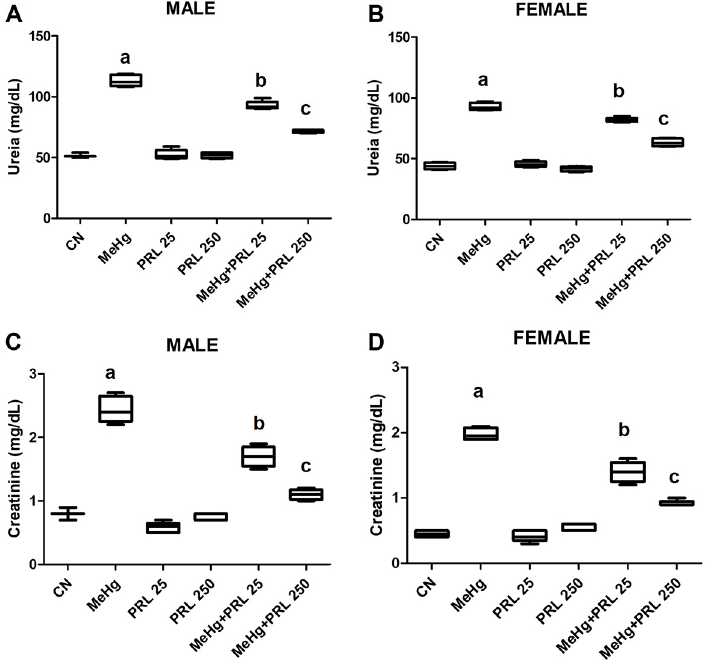
Figure 6. Renal markers in males ( A and C ) and females ( B and D ) of each treatment group. Data are reported as medians and interquartile range. a,b,c P o 0.01 compared to all other treatments (ANOVA with Tukey ’ s post-test). CN: control group; MeHg: methylmercury; PRL 25 and PRL 250: 25 and 250 m g/kg prolactin, respectively, every 12